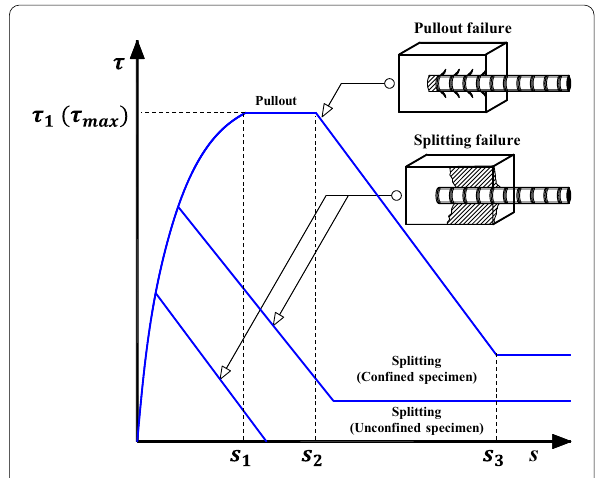
Fig. 3 Failure modes and bond–slip